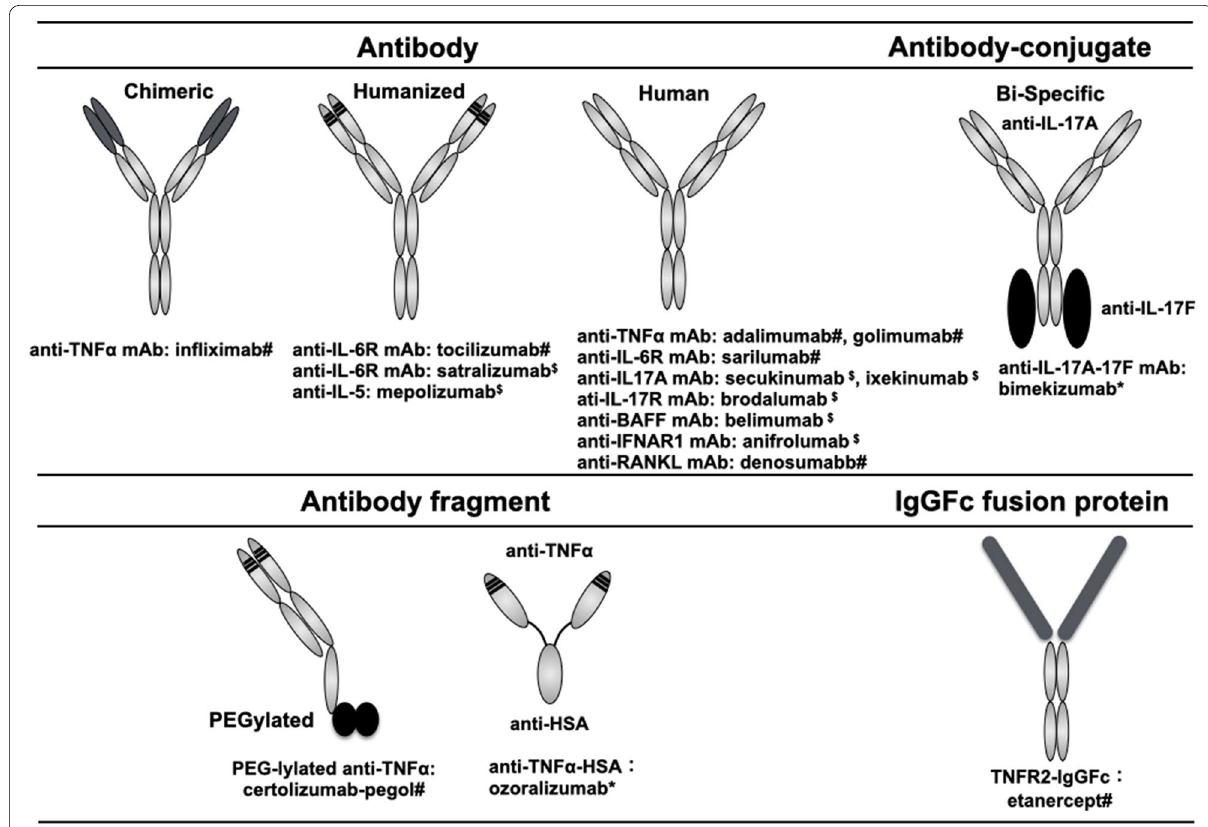
Fig. 2 Structure of biological agents used to treat immune-mediated inflammatory diseases. Gray-colored regions in the chimeric and humanized antibodies indicate mouse proteins. #Approved in Japan for RA, *not approved in Japan, $not indicated for